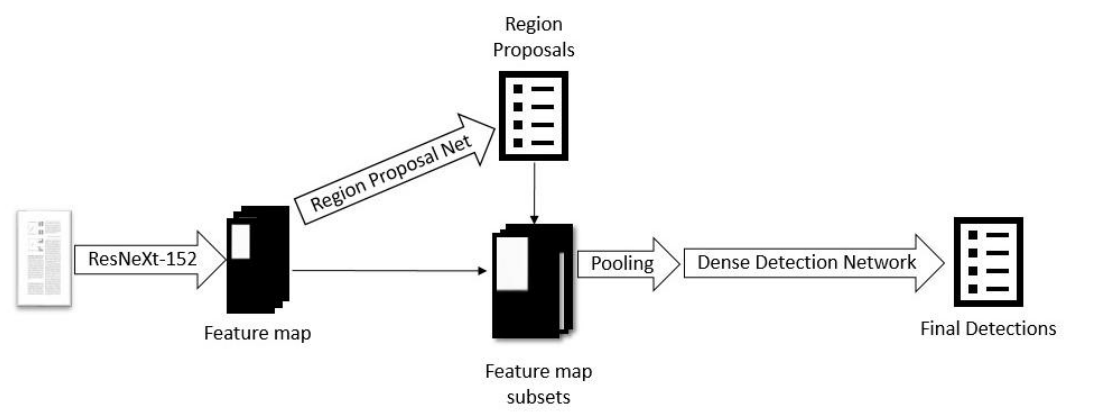
Figure 4. The Faster R-CNN